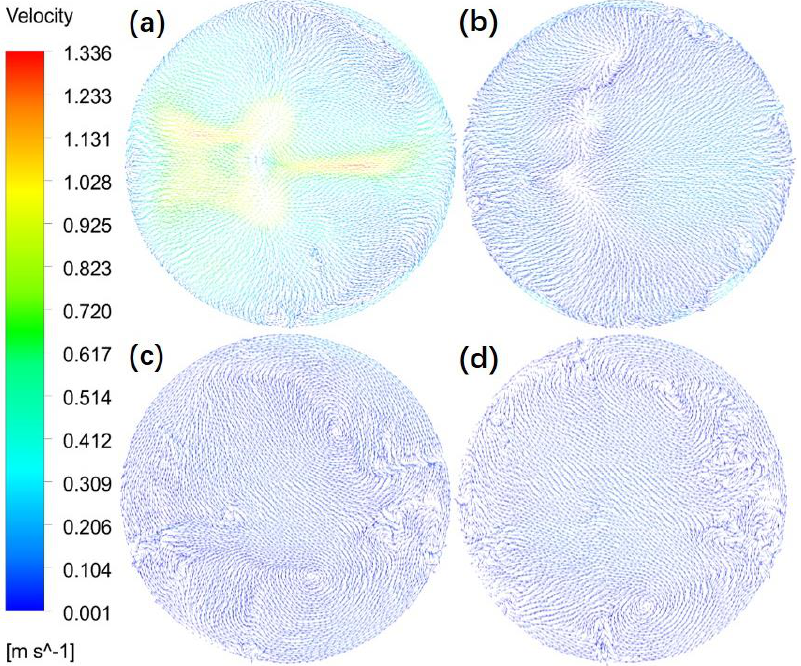
Figure 6. Flow fields along the cross-section at half of the height of the mixture when stood for ( a ) 0 s, ( b ) 0.5 s, ( c ) 1.0 s and ( d ) 1.2 s.